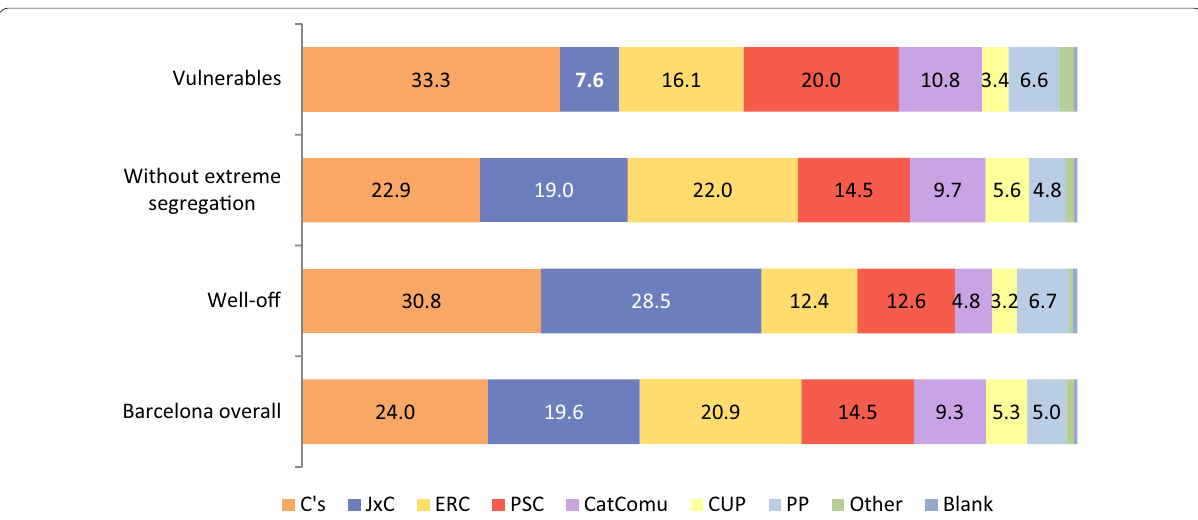
Fig. 5 Elections to the Parliament of Catalonia in December 2017, Barcelona. Results according to the segregation of the census tracts. Political parties [Source: Own elaboration from the data provided by the Generalitat de Catalunya and Barris i crisi (Blanco and Nel